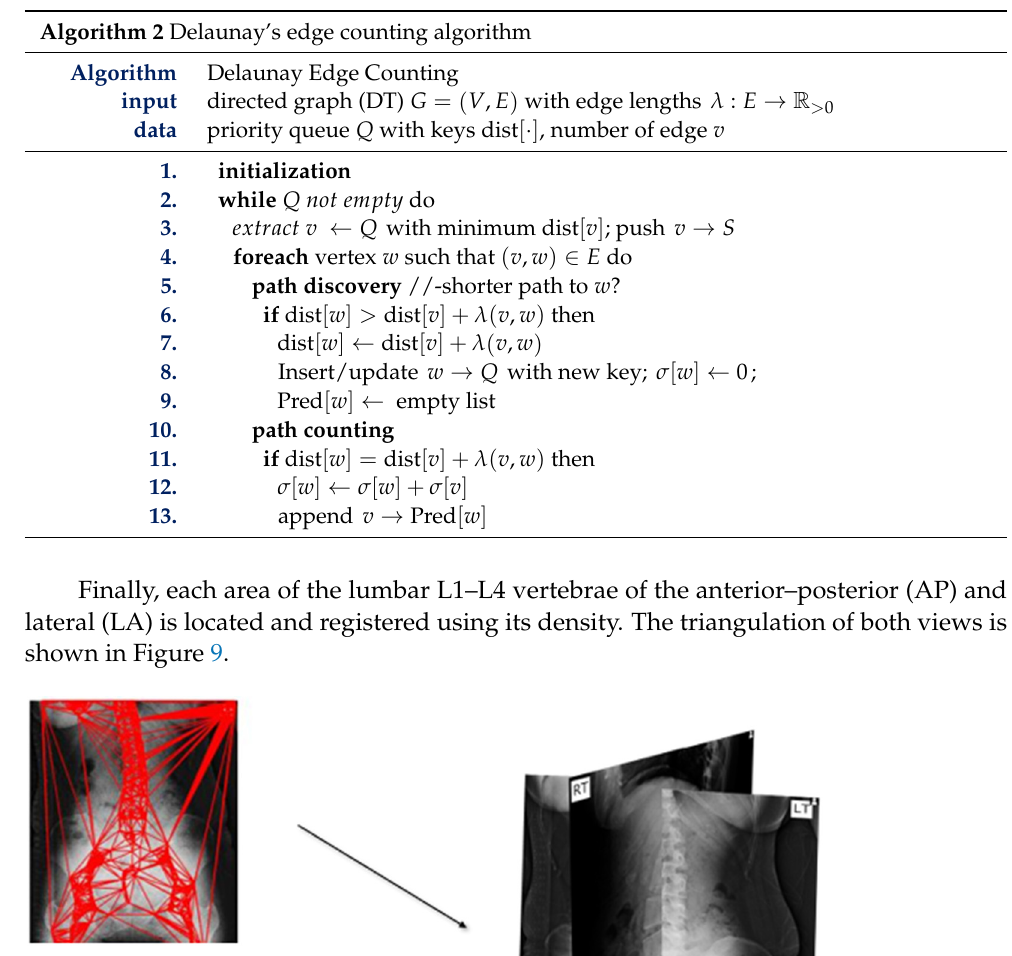
Table 2. Experimental result using confusion matrix.